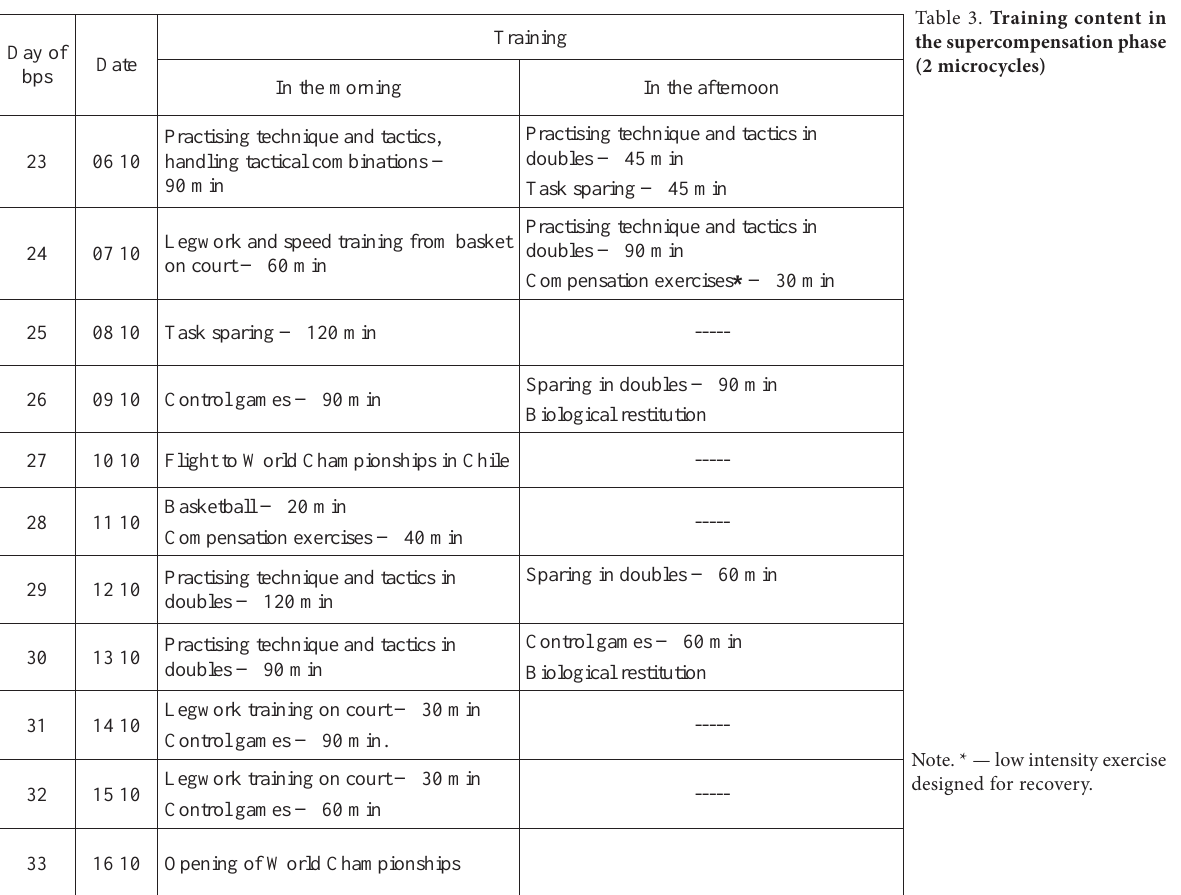
Table 3. Training content in the supercompensation phase (2